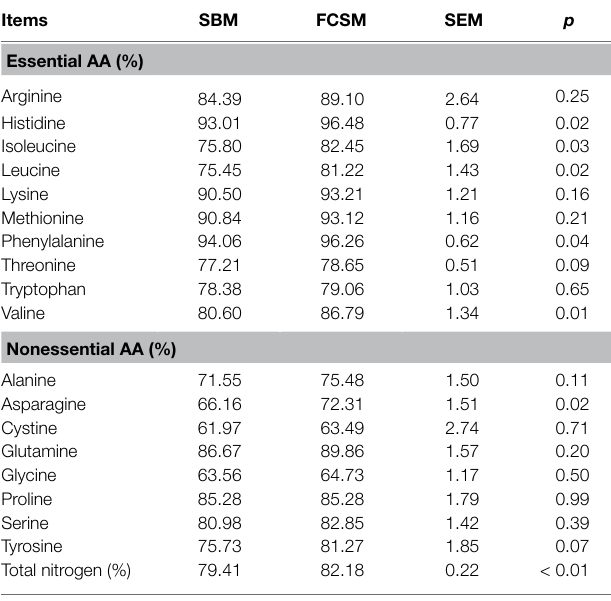
TABLE 5 | Effects of two protein source on apparent ileal digestibility of amino acids and nitrogen of weaned piglets (%). Items